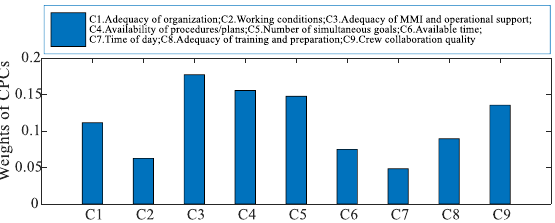
Figure 9. Weights of CPCs based on the results of Moran’s I analysis.